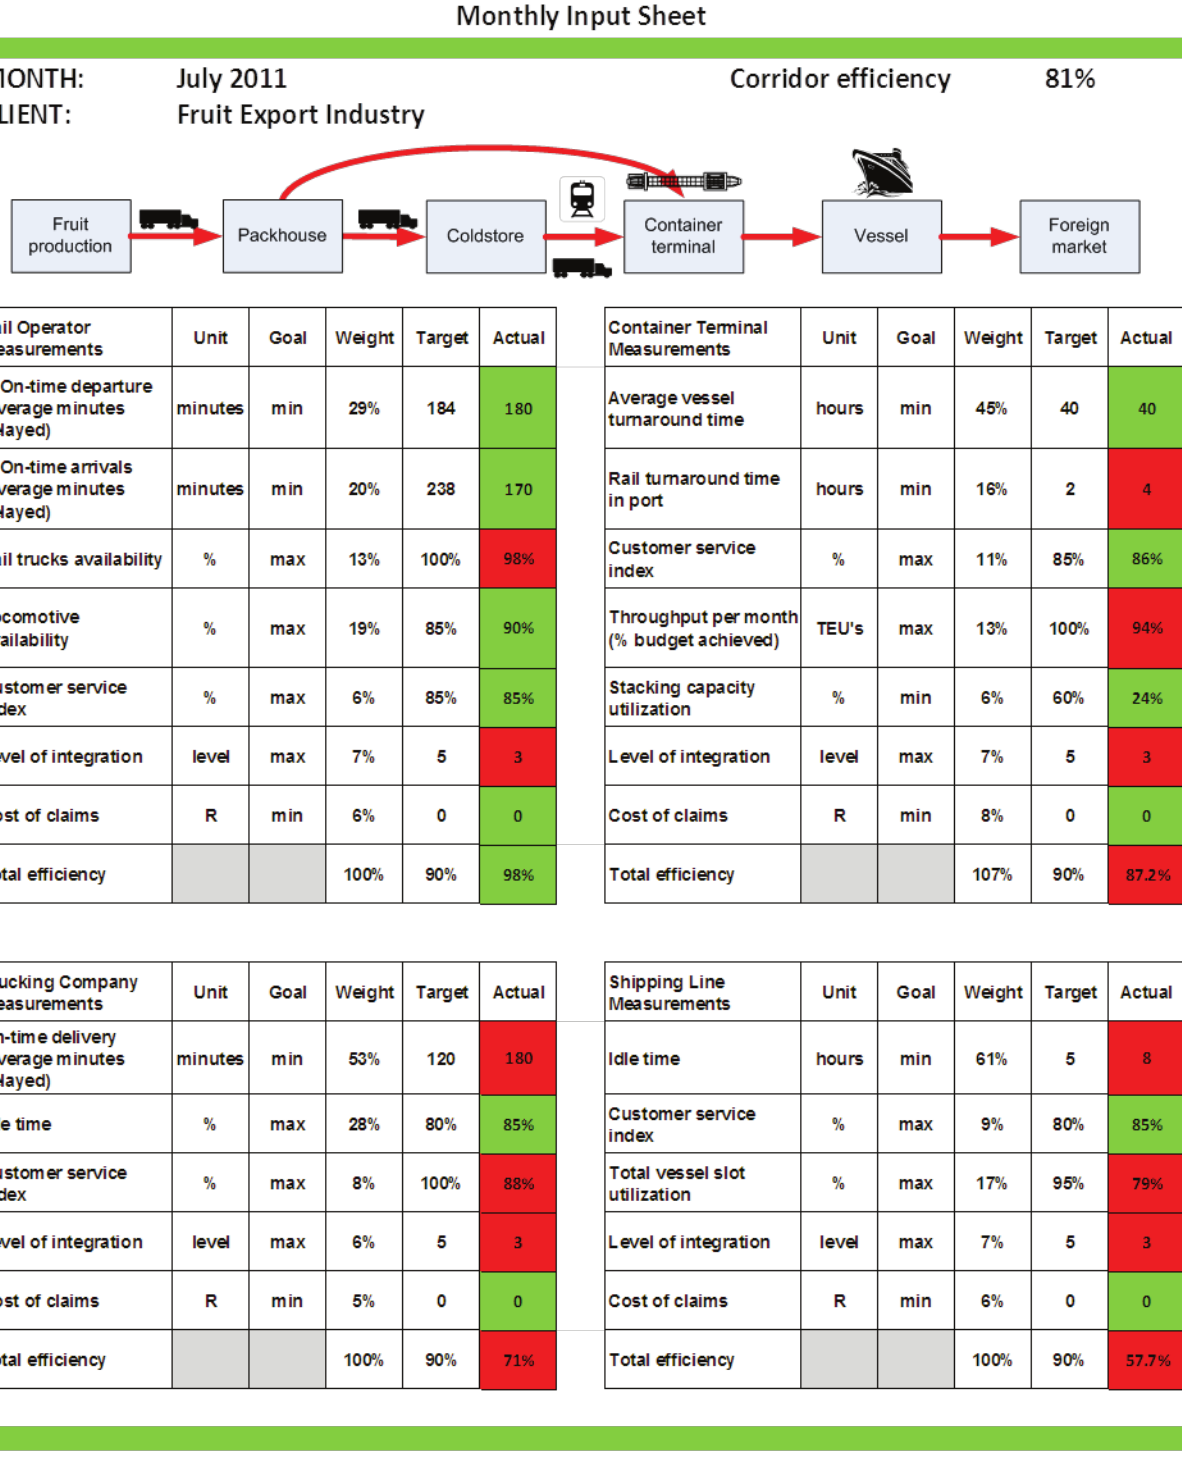
Figure 2: The performance measurement dashboard of the fruit export industry, developed in Excel